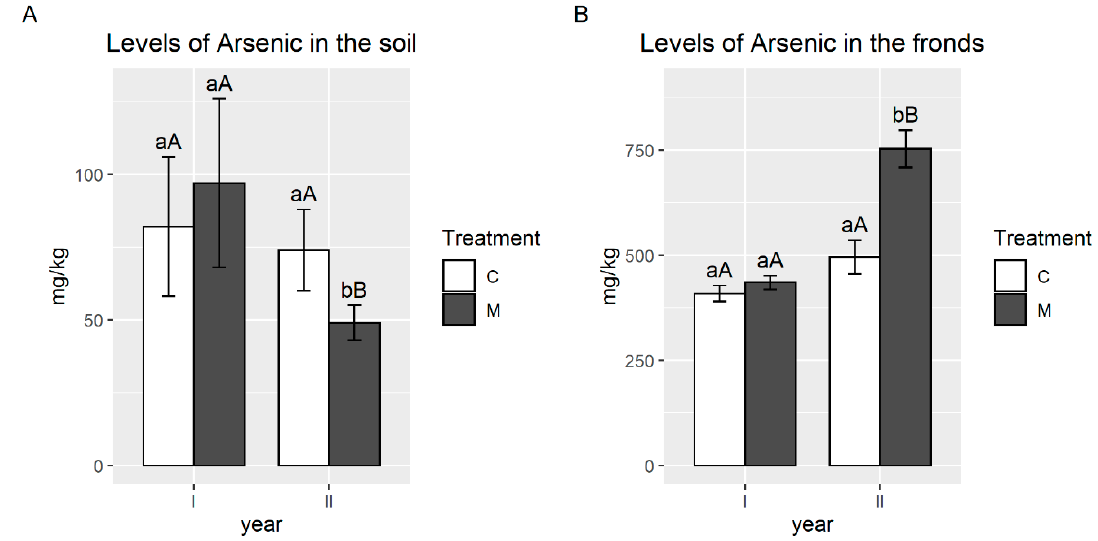
Figure 2. Arsenic average concentration (mg/kg) in soil ( A ) and aerial parts ( B ) of P. vittata plants, inoculated (M) or not (C) with a mixture of AMF, in the pot experiment. Different lower-case letters indicate a significant difference in the same year and different capital letters indicate a significant difference between the years ( p -value < 0.05). Error bars indicate standard errors.